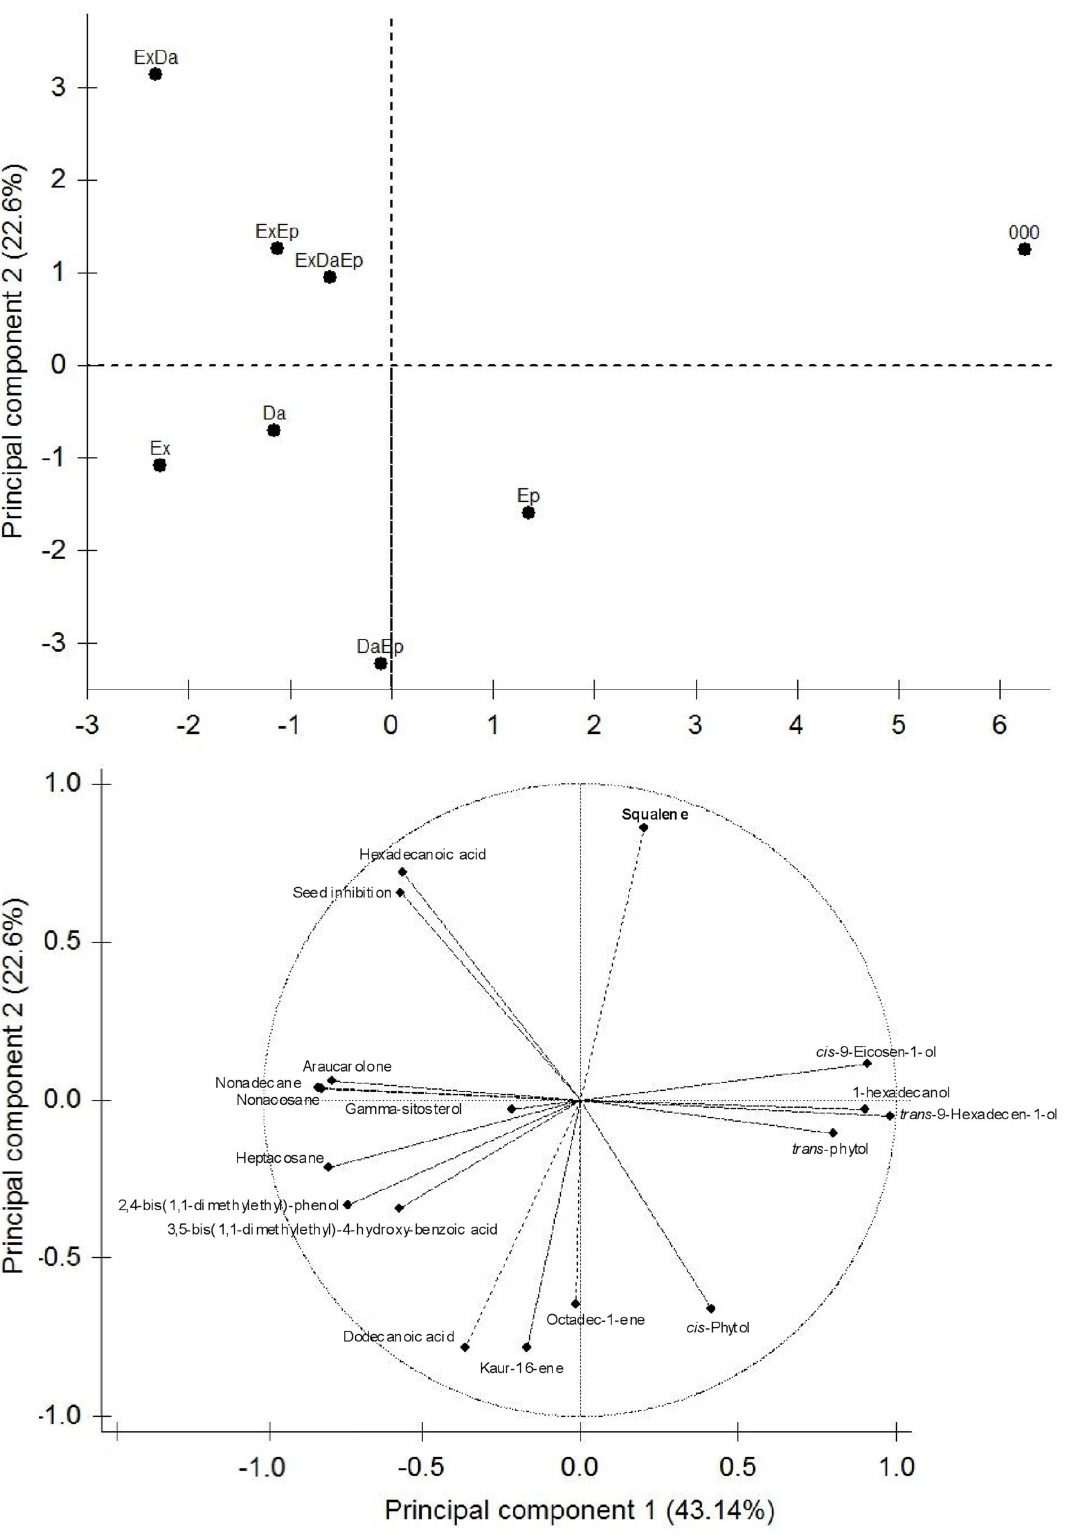
Fig 1. Principal components based on the chemical compounds found in dichloromethane extracts from eight branch treatments (see methods) also is shown the correlation projections of each chemical compound. Branches excluded (Ex), damaged branches (Da), Presence of epiphytes (Ep), control means those branches without any treatment